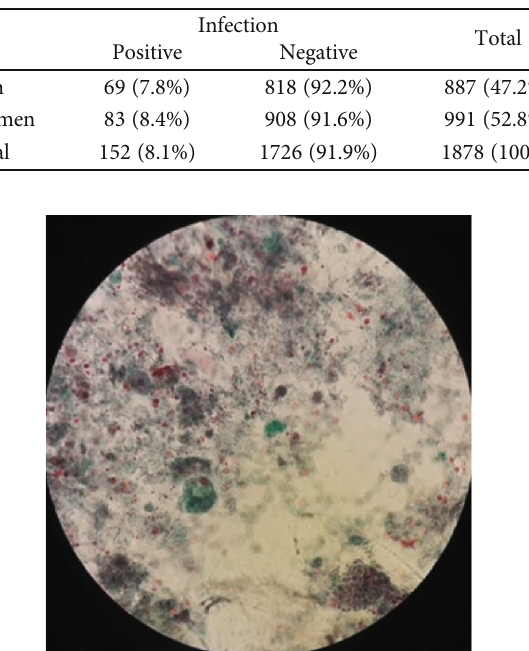
Figure 1: The presence of Blastocystis spp. in the background with tri-chrome